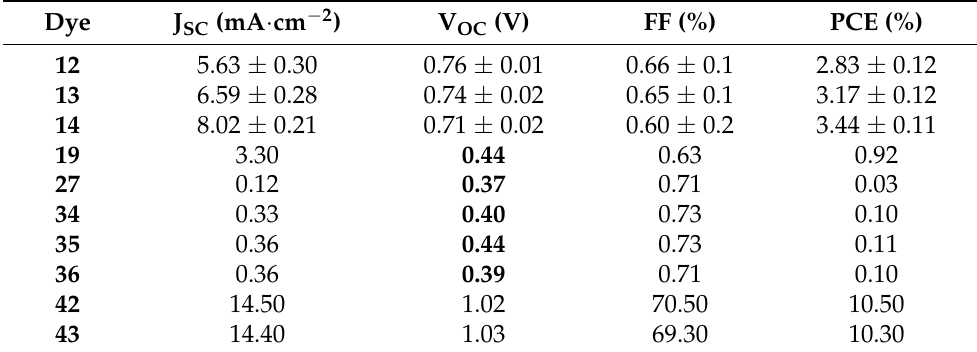
Table 3. Performance benchmarks for DSSCs utilizing selected compounds presented in Figures 4 and 5. Reprinted from [27,30] with permission of Elsevier and from [28] under a Creative Common CC BY